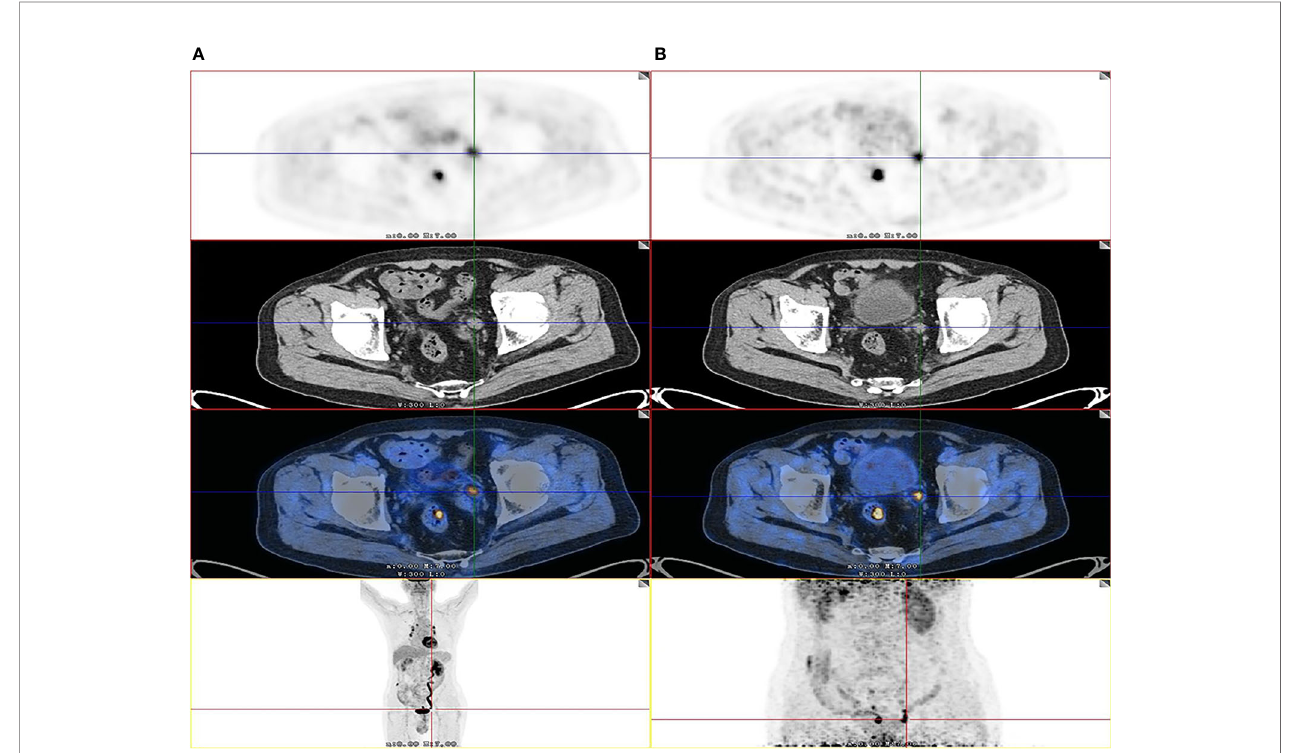
FIGURE 1 | Images of a 82-year-old patient with urothelial carcinoma. On the F-18 FDG PET/CT images, CT show that the thickening was located in left lower ureter. However, the FDG uptake of lesion was unable to detect due to urine interference in the early image (A) . On the delayed phase, the ureter is distended and lesion can be easily visualized by axial CT and PET (SUVmax, 12.2) (B) as the SUVmax of urine was decreased. The patient received radical ureterectomy, and high- grade papillary urothelial carcinoma was con fi rmed by